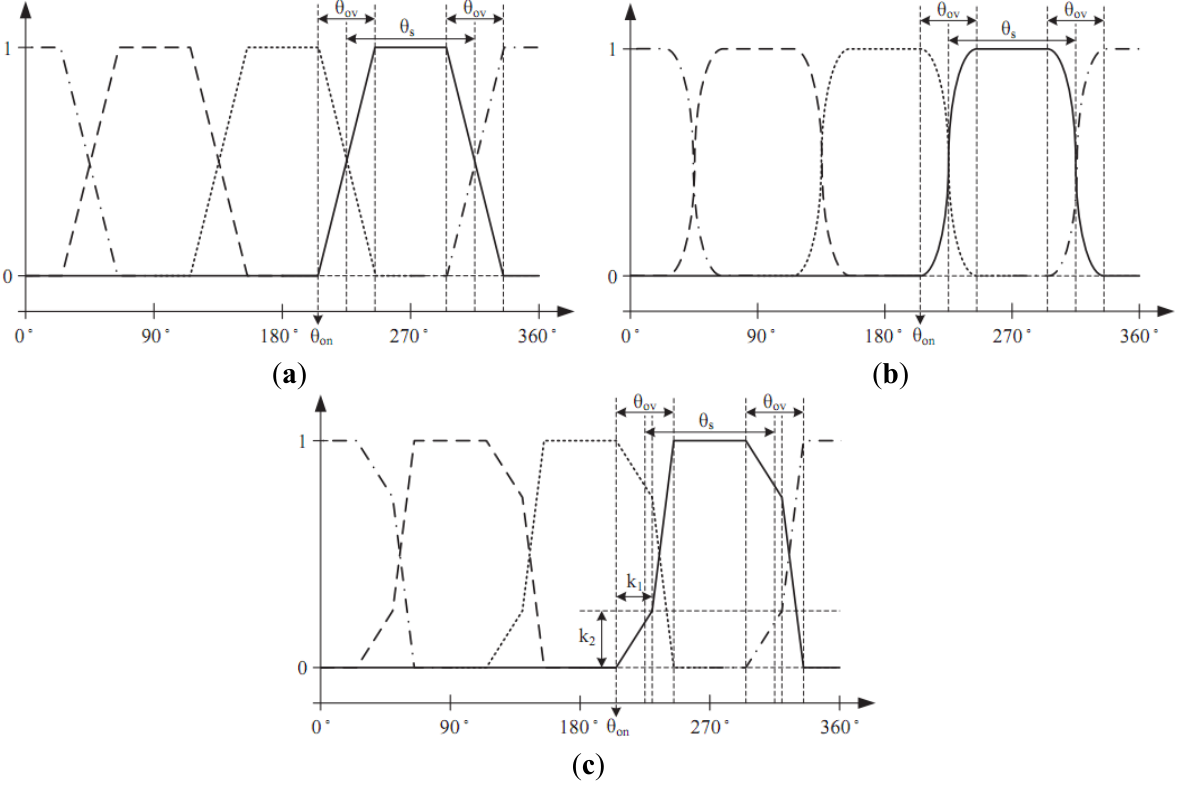
Figure 5. Typical profiles: ( a ) linear TSF; ( b ) nonlinear TSF; ( c ) asymmetric